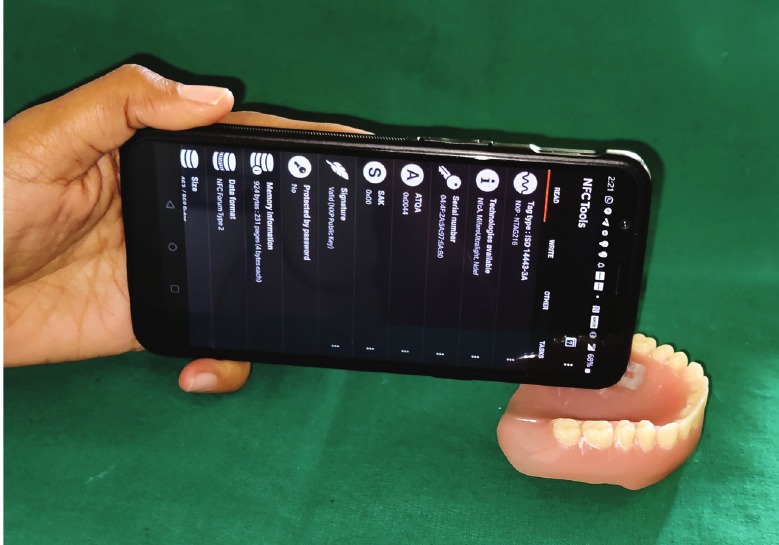
Figure 8: NFC tag detected.